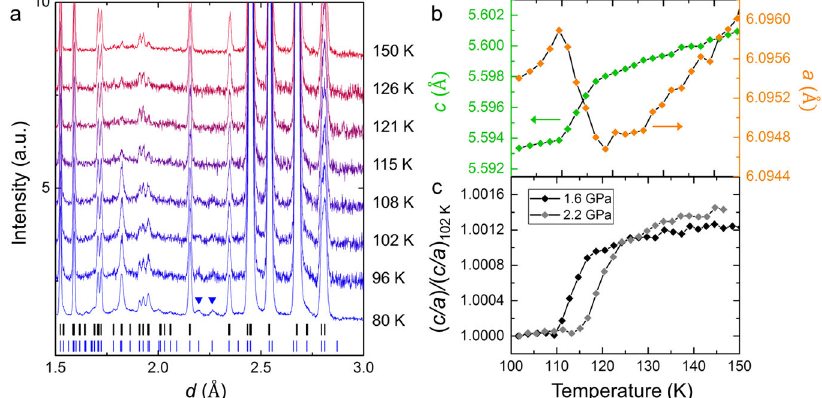
Fig. 3 Temperature dependence of neutron diffraction patterns and lattice parameters of DCl-doped D 2 O ice VI and ice XIX. a Neutron diffraction patterns of ice VI and XIX obtained at 1.6 GPa in the cooling run. Only an expanded area showing new peaks of ice XIX is displayed. The blue and black ticks represent all the peak positions expected from the unit cells of ice XIX and ice XV, respectively. Blue triangles indicate new peaks at 2.20 Å and 2.26 Å , which do not appear from the unit cell of ice XV. b Temperature dependence of lattice parameters, a and c , of ice VI or ice XIX obtained at 1.6 GPa. The values were calculated based on the ice VI structure model even for ice XIX because of a common oxygen framework between ice VI and XIX. c Temperature dependence of c / a at two different pressures, 1.6 and 2.2 GPa, indicated by black and grey. Phase transition from ice VI to ice XIX started at around 117 K and 124 K in the respective cooling runs. The c / a values are normalised by that at 102 K. Diffraction patterns were collected using new samples in each run under different pressures to con fi rm